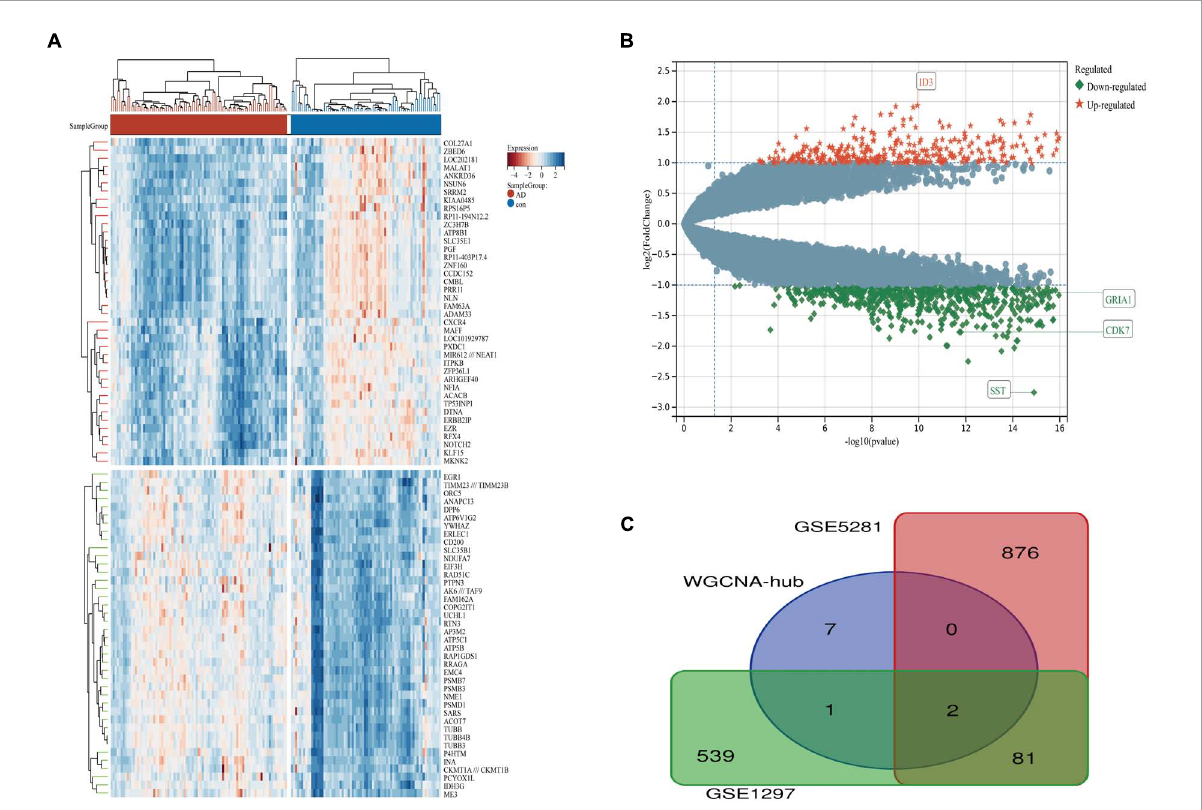
FIGURE6 The volcano plot, heat map, and Venn diagram of DEGs. (A) A heat map of DEGs in GSE5281. (B) Volcano plot of DEGs in GSE5281. (C) Venn diagram of GSE5281, GSE1297, and WGCNA-hub. There are also two horizontal dashed lines in the panel (B) , representing log2FC at –1 and 1, The vertical dashed line represents the adjusted p -value at 0.05, ID3 and SST represented the genes with the largest and smallest difference, respectively. GRIA1 and CDK7 are the key genes in this study.